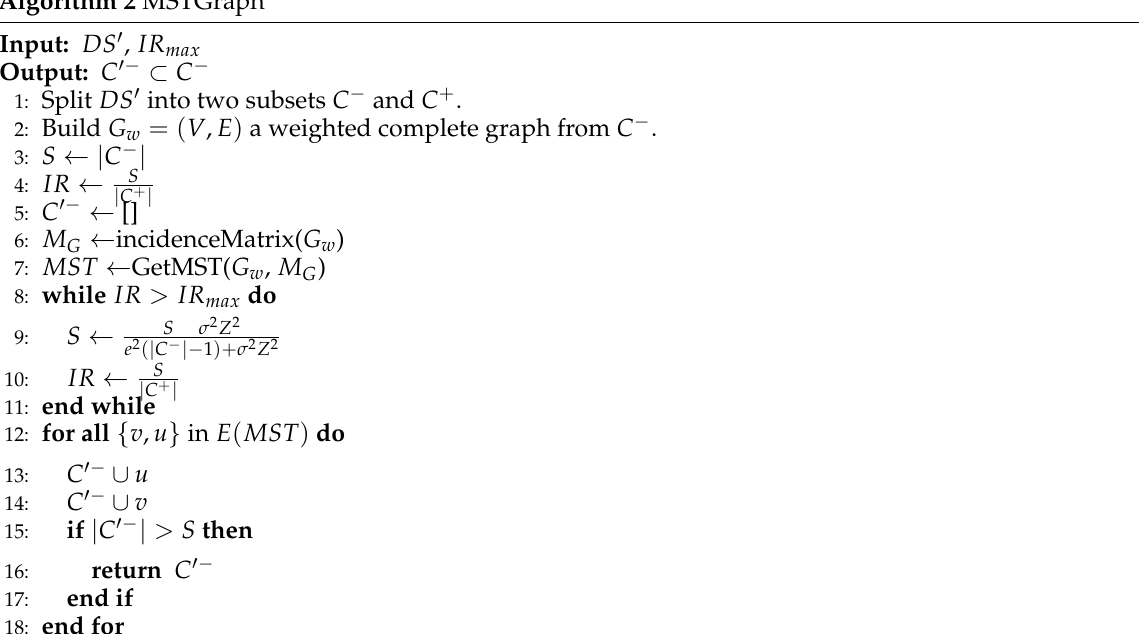
Algorithm 2 MSTGraph